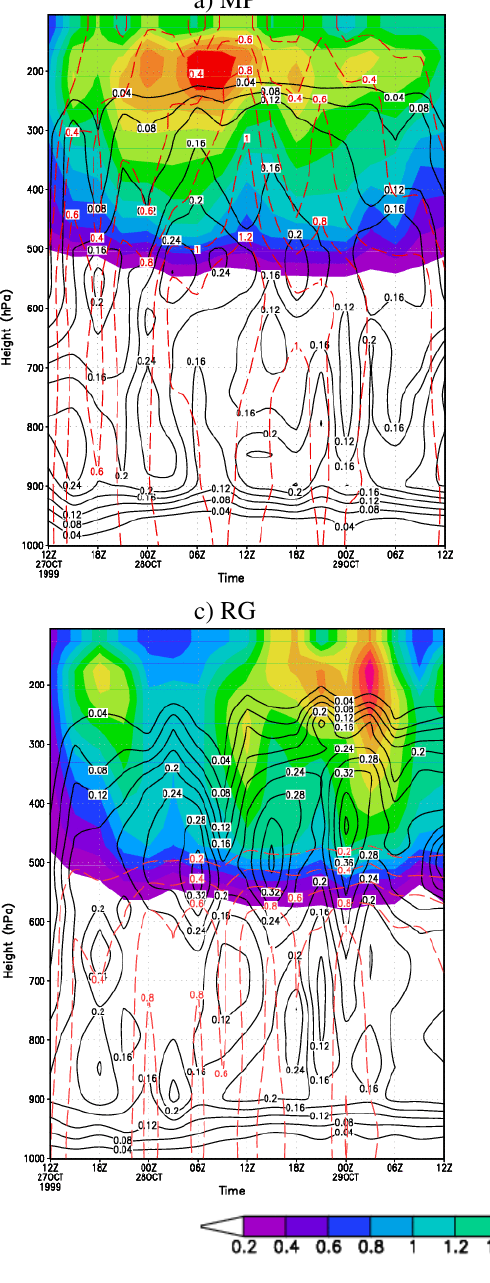
Fig. 13. Same as Fig. 8 but for the experiments with different MPS, namely (a) MP, (b) GG, (c) RG and (d)